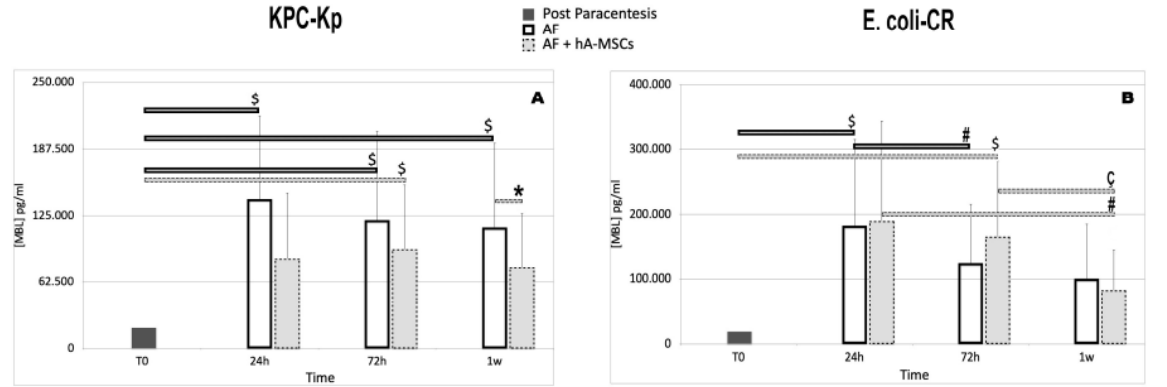
Figure 7. Mannose-binding lectin analysis using WBCs derived from ascites of cirrhotic patients co-cultured, with or without hA-MSCs, for the time point chosen (24 h, 72 h, and 1 week) after KPC-Kp ( A ) and E. coli-CR infection ( B ). Statistics were obtained comparing with T0 ($), 24 h (#), and 72 h (ç) and comparing AF plus hA-MSCs versus Control 2 at the same time (*). ( A ) WBCsAF grown without hA-MSCs (Control 2) had a significant increase in MBL at all times, compared to T0 ( p < 0.05, $). Interestingly, not only did the MBL concentration in presence of hA-MSCs increase significantly only at 72 h with respect to T0, but its concentration was also significantly lower at 1 week compared to WBCs without hA-MSCs. ( B ) The hA-MSC effect was significantly relevant at 1 week, as there was a decrease in MBL compared to both 24 h and 72 h ( p < 0.05, ç #). Only at 72 h the WBCs plus hA-MSCs condition showed a significant increase in MBL production compared to T0, while Control 2 shows a significant increase at 24 h compared to T0 ( p < 0.05, $) and a significant decrease at 72 h when compared to 24 h ( p < 0.05, #), which remained unchanged after 1 week. Values were statistically significant when p < 0.05 (*, $, #, ç) and are expressed as means of MBL concentration in pg/mL ( n = 6) and